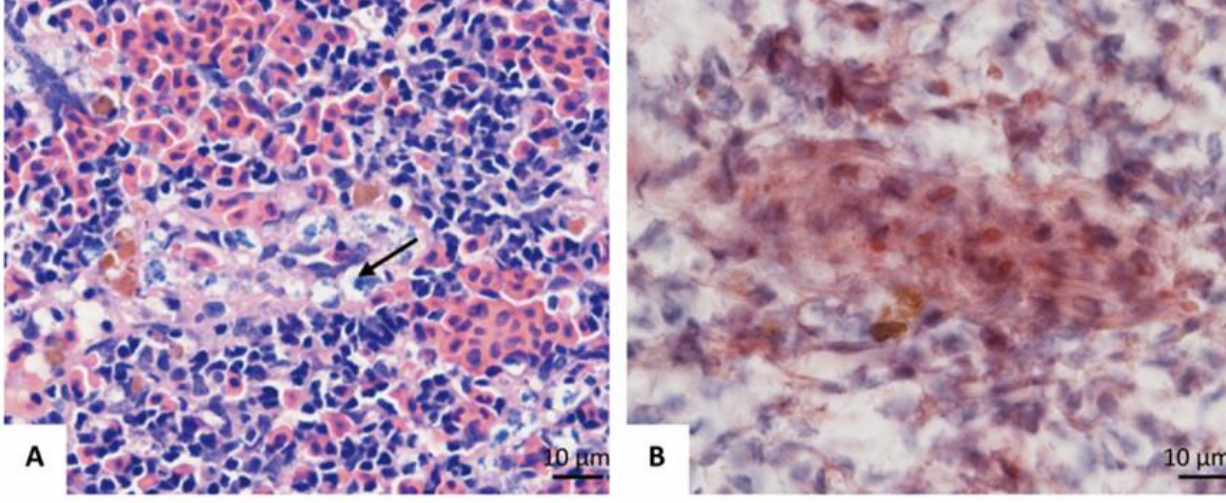
Figure 6. The location and quantification of Trypan blue and ACP (Acid phosphatase). ( A ). 8 hpi ( i.p. ), Trypan blue ( → ) appeared in the endotheliocytes of ECs; ( B ). 8 hpi ( i.p. ), ACP expressed by the endotheliocytes of ECs; ( C ). Area and IOD of Trypan blue detected using IPP 6.0 from 0 – 72 hpi ( i.p. ); ( D ). Area and IOD of ACP detected by IPP 6.0 from 0 – 24 hpi ( i.v. ). “ ★ ” : significantly different ( p < 0.05). ACP was mainly expressed in the endotheliocytes of ECs in normal spleens (Figure 6B). At 4 hpi ( i.p. ), the expression of ACP upregulated slightly judging from the area and IOD, whereafter the area and IOD increased significantly at 8 hpi when both the endothe- liocytes of ECs and the cells of the splenic cords expressed ACP. Following 24 – 72 hpi, the IOD of ACP declined to the normal level, but the area of ACP was significantly broader than that in normal spleens (Figure 5G – I). The correlation analysis between the Trypan blue and ACP suggested that the Try- pan blue was positively correlated with the ACP (Table S1). 4. Discussion The spleen is a critical organ in immunity of teleost [26]. A larger spleen is regarded as an indirect indicator of immunological status, and reducing the size of the spleen would accelerate the time to death post-challenged [27]. However, the underline mechanisms of the spleen in infection are still ill-defined. To lay basic information for further research, we focused on presenting the splenic structure and the BSB in Nile tilapia. We studied the histology of the spleen and explored the location and function of BSB. We portion the